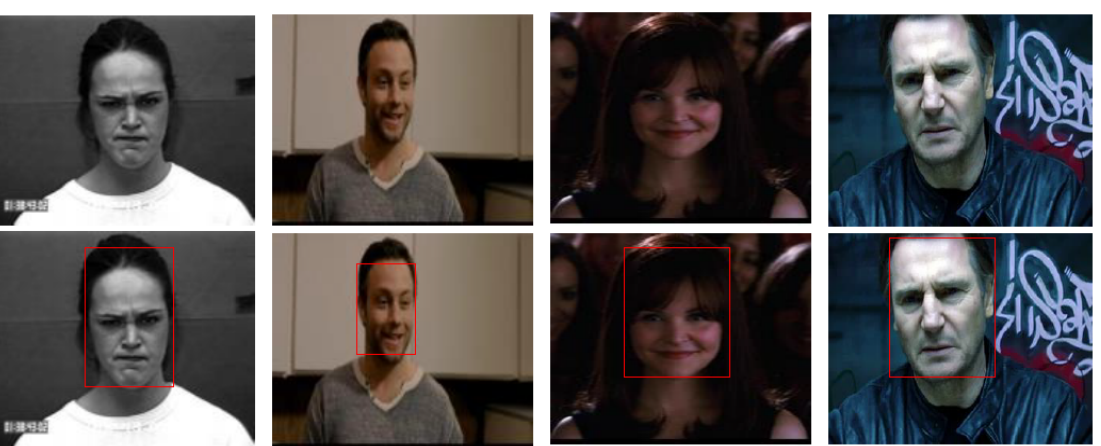
Figure 2. Face detection results of the trained model. Only the detected bounding box region of the whole frame is used to classify the facial